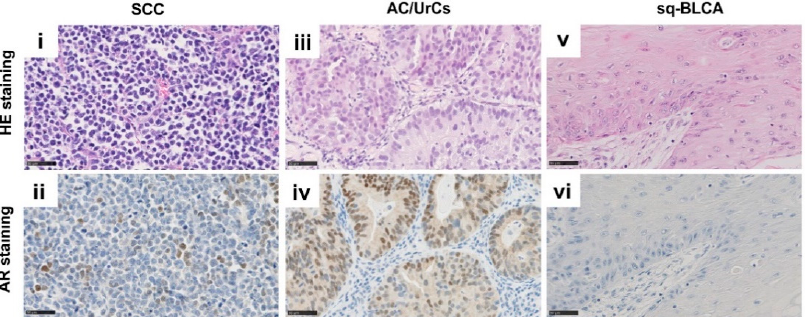
Figure 2. HE and immunohistochemical anti-AR staining of SCC ( i , ii ), AC/UrCs ( iii , iv ), and Sq- BLCA ( v , vi ) tissues, respectively. Scale bar: 50 µm. Table 3. Immunohistochemical results of hormone receptors in histological subtypes of bladder can- cer.